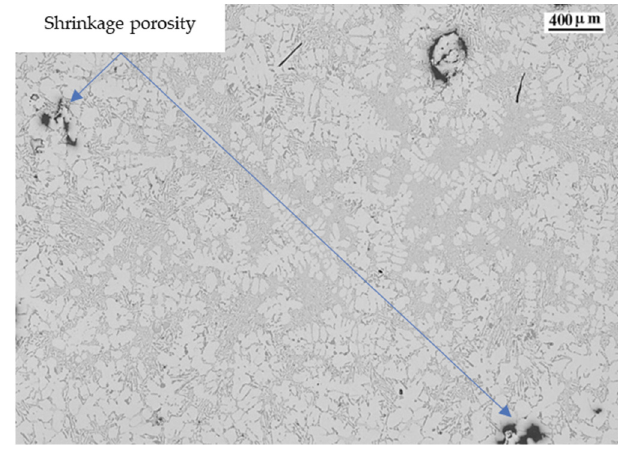
Figure 10. Microstructure of alloy